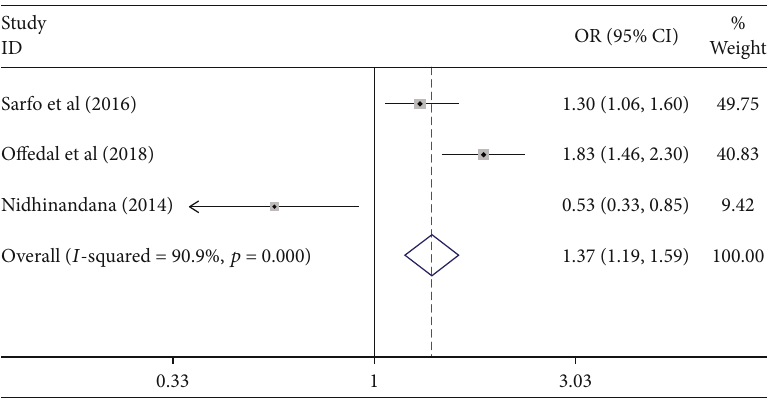
Figure 4: E ff ect size of use of antihypertensive drugs on the uncontrolled hypertension.